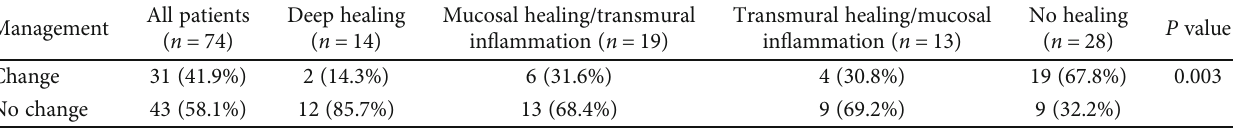
Table 4: Impact of in fl ammatory activity based on magnetic resonance enterography and colonoscopy on management changes.